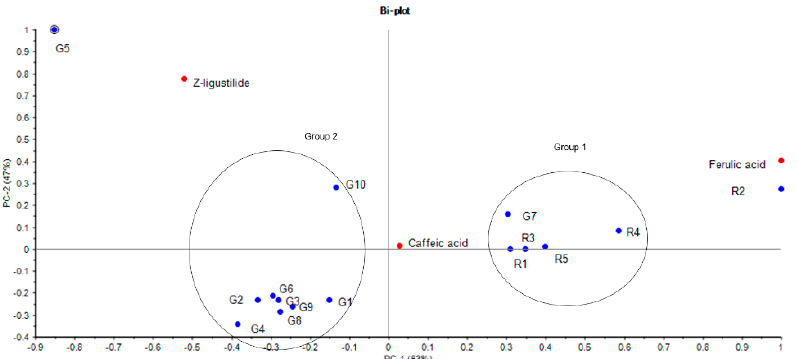
Figure 3. Biplot from principal component analysis (PCA) of Danggui samples (PC1 vs PC2) based on the three components Z-ligustilide, caffeic acid and ferulic acid using Unscrambler 10.3 from Camo AS software (Trondheim, Norway). In the biplot, a point represented each individual sample, and the distance allocated between samples, revealed the degree of their similarity in terms of the content of the chemical markers. PC: principal component. G: granule samples; R: raw herbs/decoction piece samples. Group 1: R1, R3, R5, G7, R4; Group 2: G1, G2, G3, G4, G6, G8, G9.